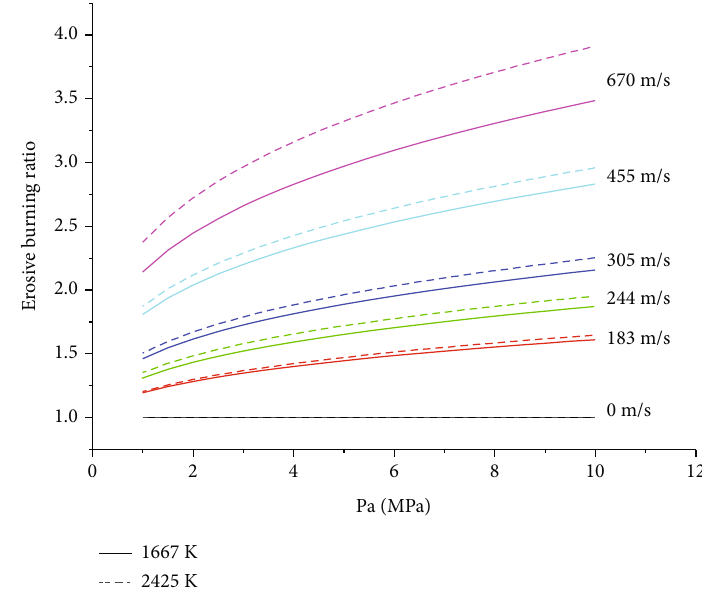
Figure 7: Erosive burning ratio of propellant 4525 at di ff erent core gas temperatures.